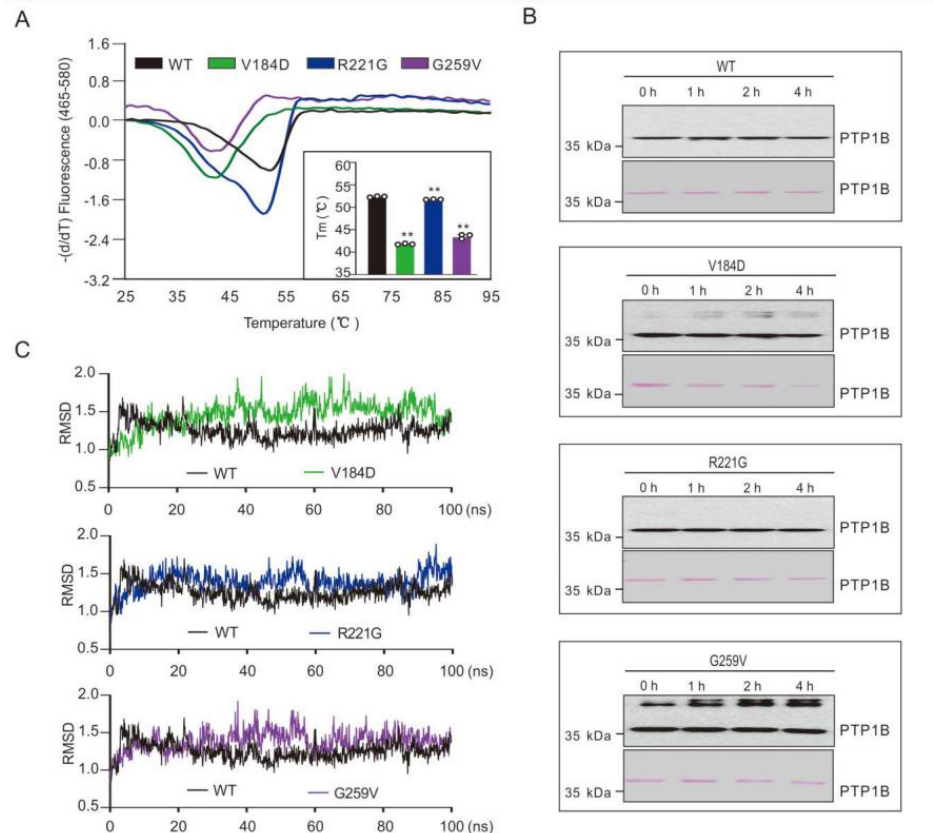
Figure 3. Evaluation of the PTP1B protein stability in the WT and mutants. ( A ) Thermal shift assay of the PTP1B proteins (5 µM) in the presence of 10 X SYPRO in the WT and mutants. T m values were determined from the first-order derivative of the fluorescence as a function of temperature. Data are presented as the mean of three independent experiments ± SD. ** p -value < 0.01 (compared to WT PTP1B). ( B ) The PTP1B proteins (10 μg) were in cubated at 37 °C; aliquots of the solution were taken at different time points (0, 1, 2, 4 h), separated by SDS - PAGE, and subjected to PTP1B immunode- tection following Ponceau staining. The membrane shown is representative of three independent experiments. ( C ) Molecular dynamics simulation of the PTP1B proteins in the WT and mutants was conducted for 100 ns using Amber20 software (PTP1B PDB code: 2HNP). Data were extracted with VMD and presented in the form of RMSD.